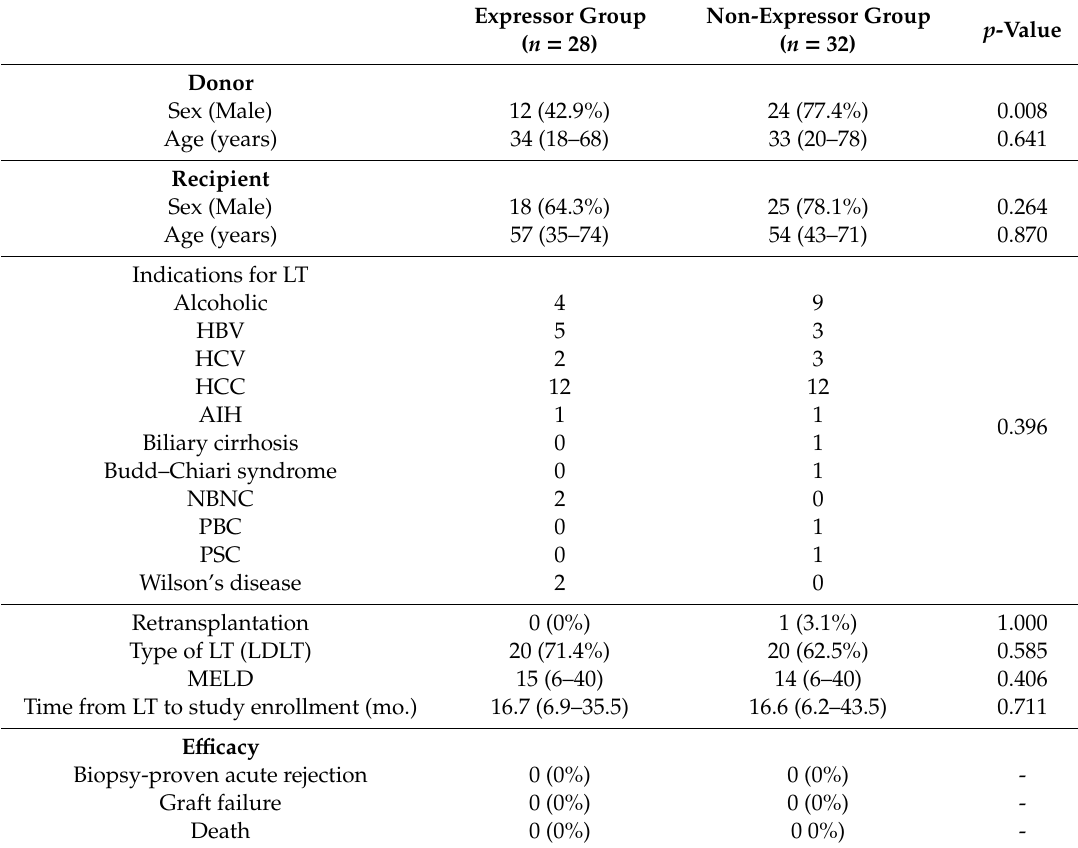
Table 1. Characteristics and e ffi cacy of the study patients stratified according to CYP3A5 expression.